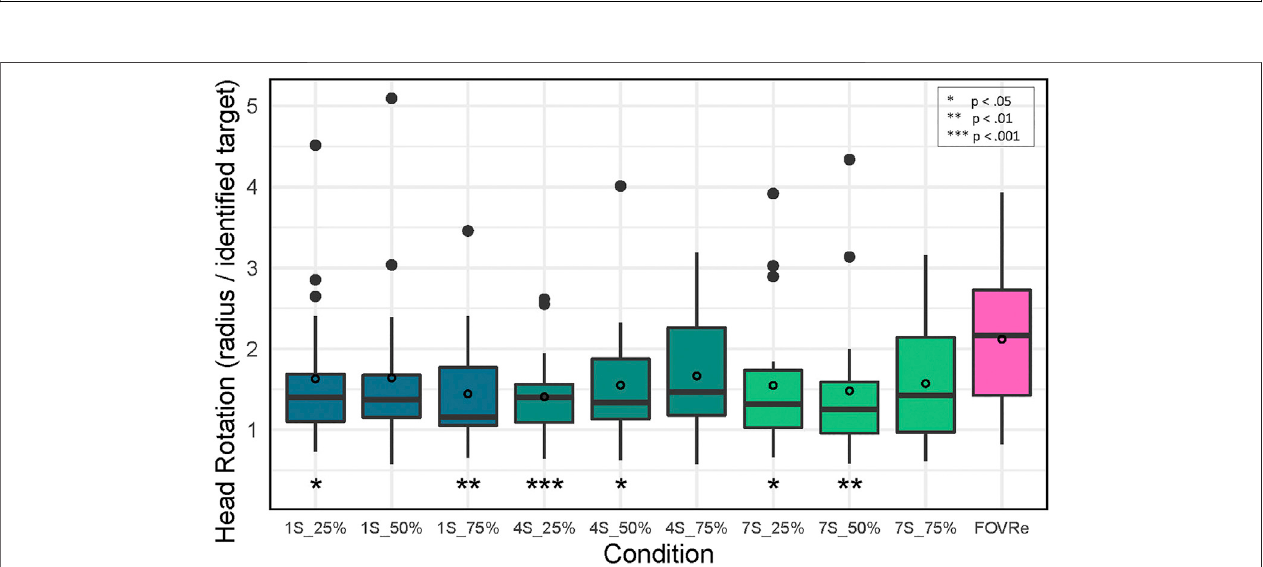
FIGURE 7 | Amount of head rotations to identify the targets. Each variation of GRFs is compared with FOV Restrictors. GRF combinations 1S_25% ( M (cid:2) 1 . 630 ± 0 . 902), 1S_75% ( M (cid:2) 1 . 442 ± 0 . 699), 4S_25% ( M (cid:2) 1 . 406 ± 0 . 524), 4S_50% M (cid:2) 1 . 550 ± 0 . 753), 7S_25% ( M (cid:2) 1 . 546 ± 0 . 832), 7S_50% ( M (cid:2) 1 . 480 ± 0 . 889) had signi fi cantly less amount of head rotation than FOV Restrictors condition ( M (cid:2) 2 . 120 ± 0 . 801). The signi fi cance stars represent the difference between GRF conditions and FOVRe, the circle outlines represent the mean values for each condition.